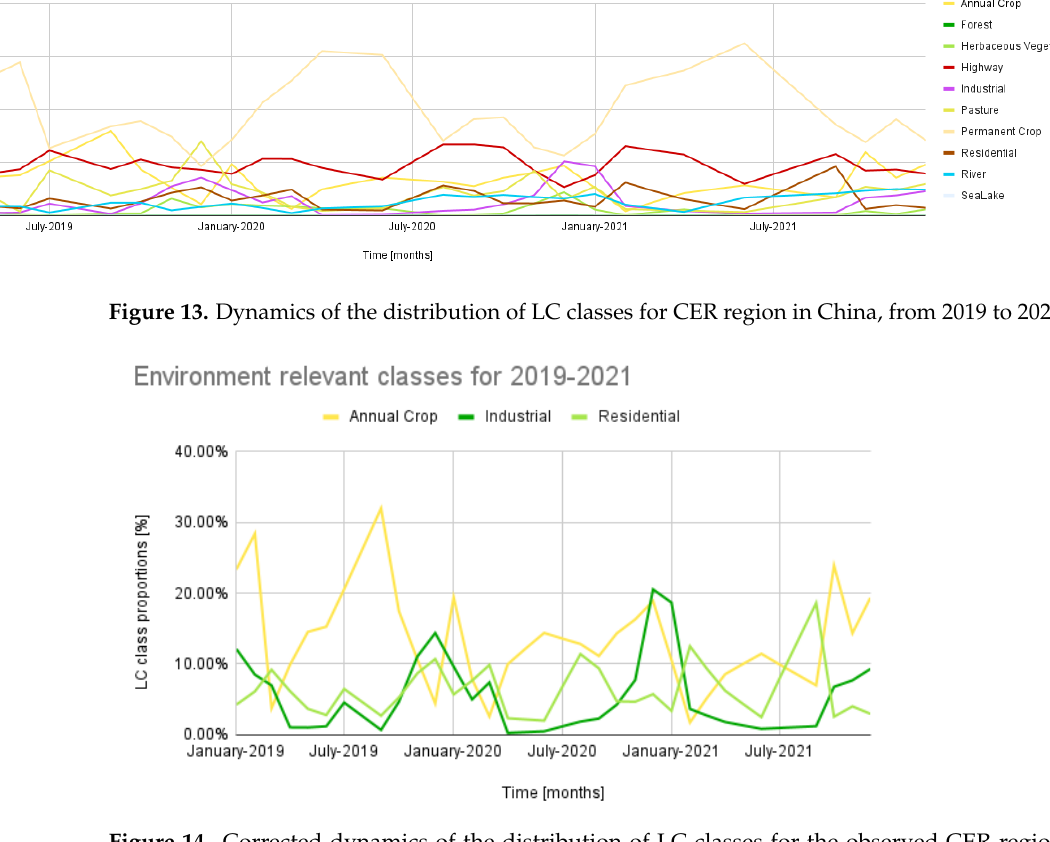
Figure 14. Corrected dynamics of the distribution of LC classes for the observed CER region in Central China, from 2019 to 2021.